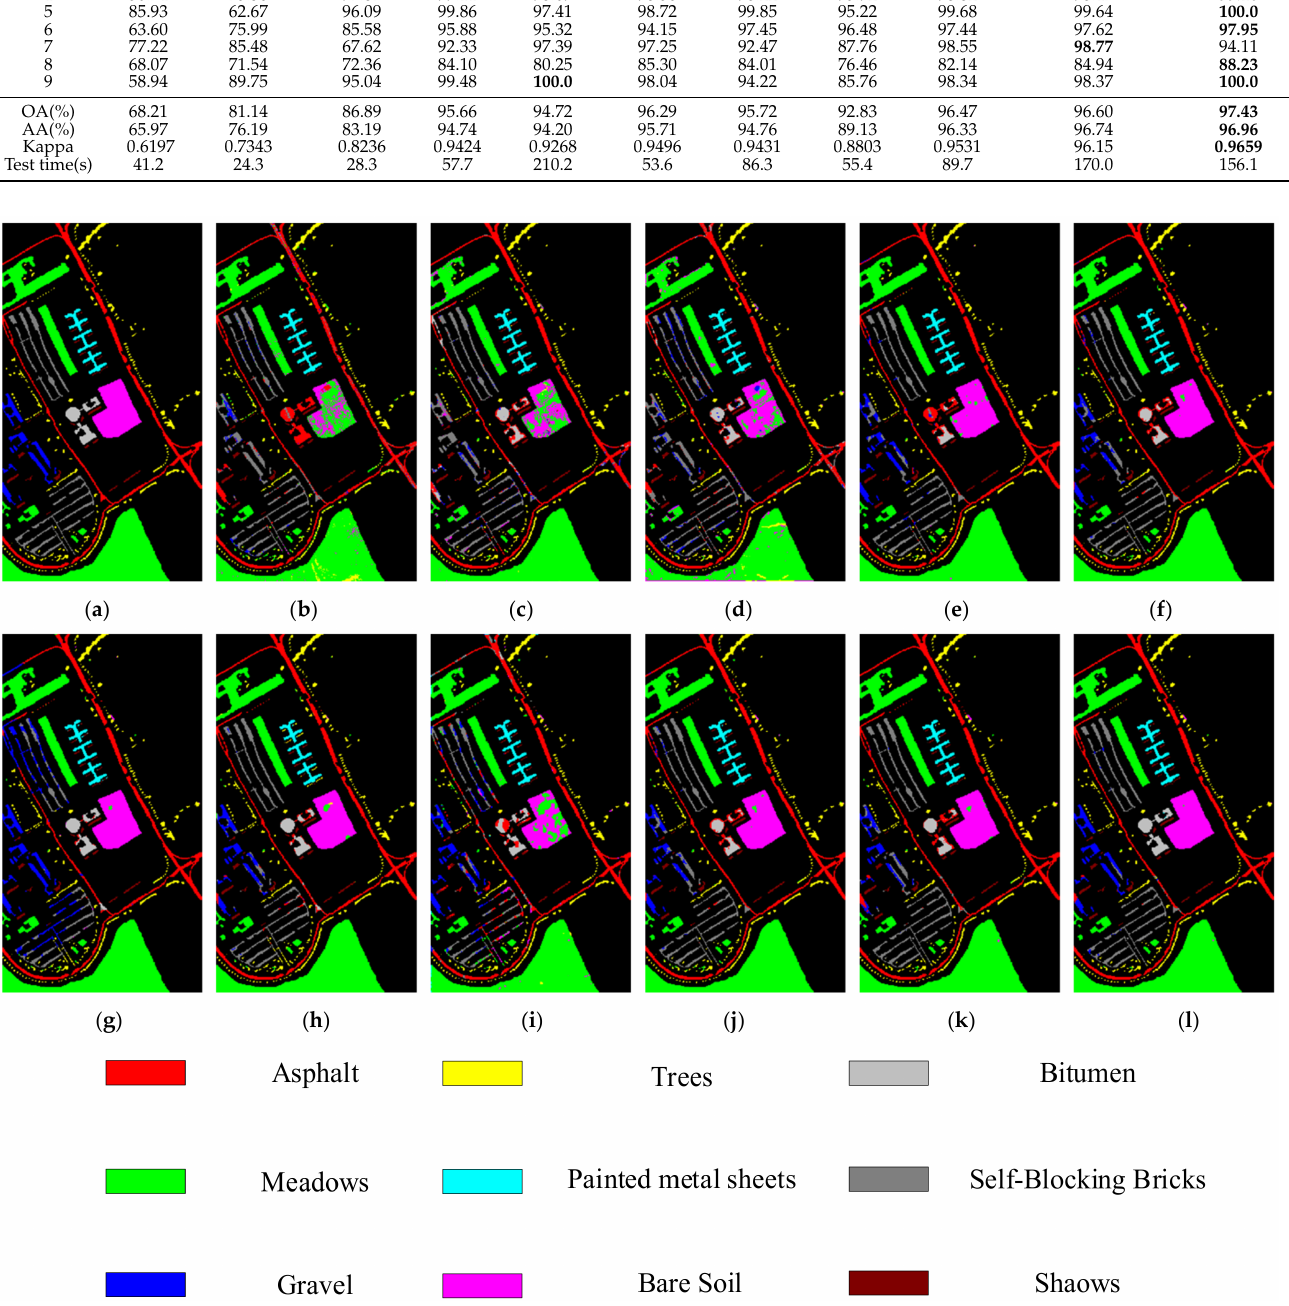
Figure 8. Full classification maps on the University of Pavia images obtained with the ( a ) ground truth, ( b ) KNN (OA = 68.21), ( c ) SVM-RBF (OA = 81.84), ( d ) CDCNN (OA = 86.89), ( e ) SSRN (OA = 95.66), ( f ) FDSSC (OA = 94.72), ( g ) DHCNet (OA = 96.29), ( h ) DBMA (OA = 95.72), ( i ) HybridSN (OA = 92.83), ( j ) DBDA (OA = 96.47), ( k ) LiteDepthwiseNet (OA = 96.60), and ( l ) proposed method (OA =